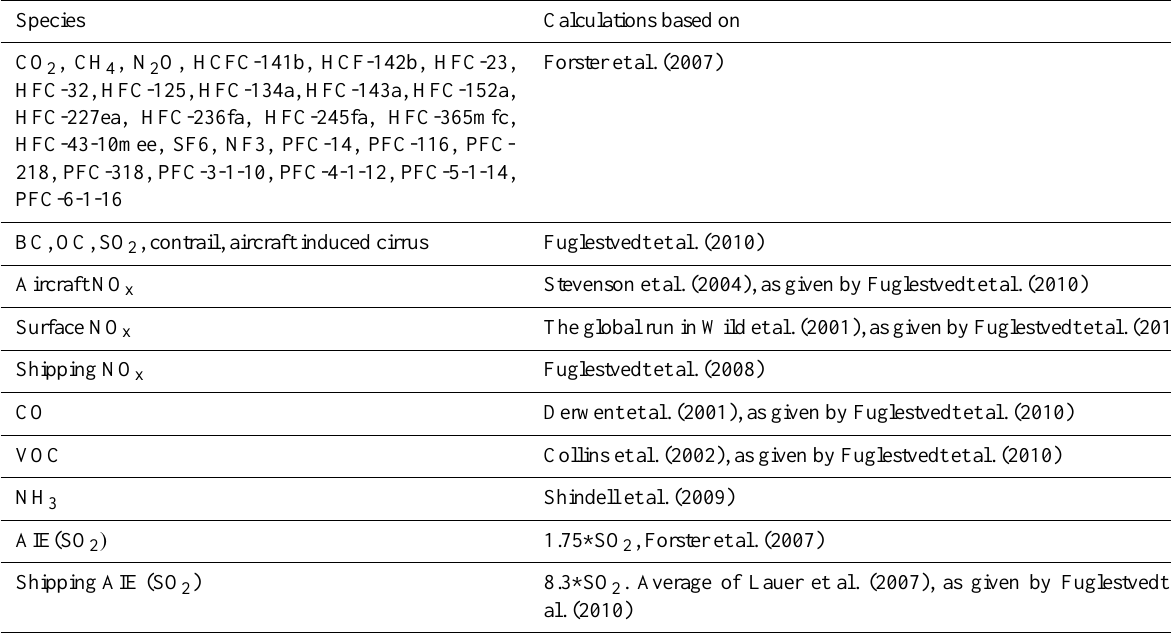
Table 3. A list of all gases, particles, and indirect effects that are included in the sample applications presented. For each species, the literature that is used for input is